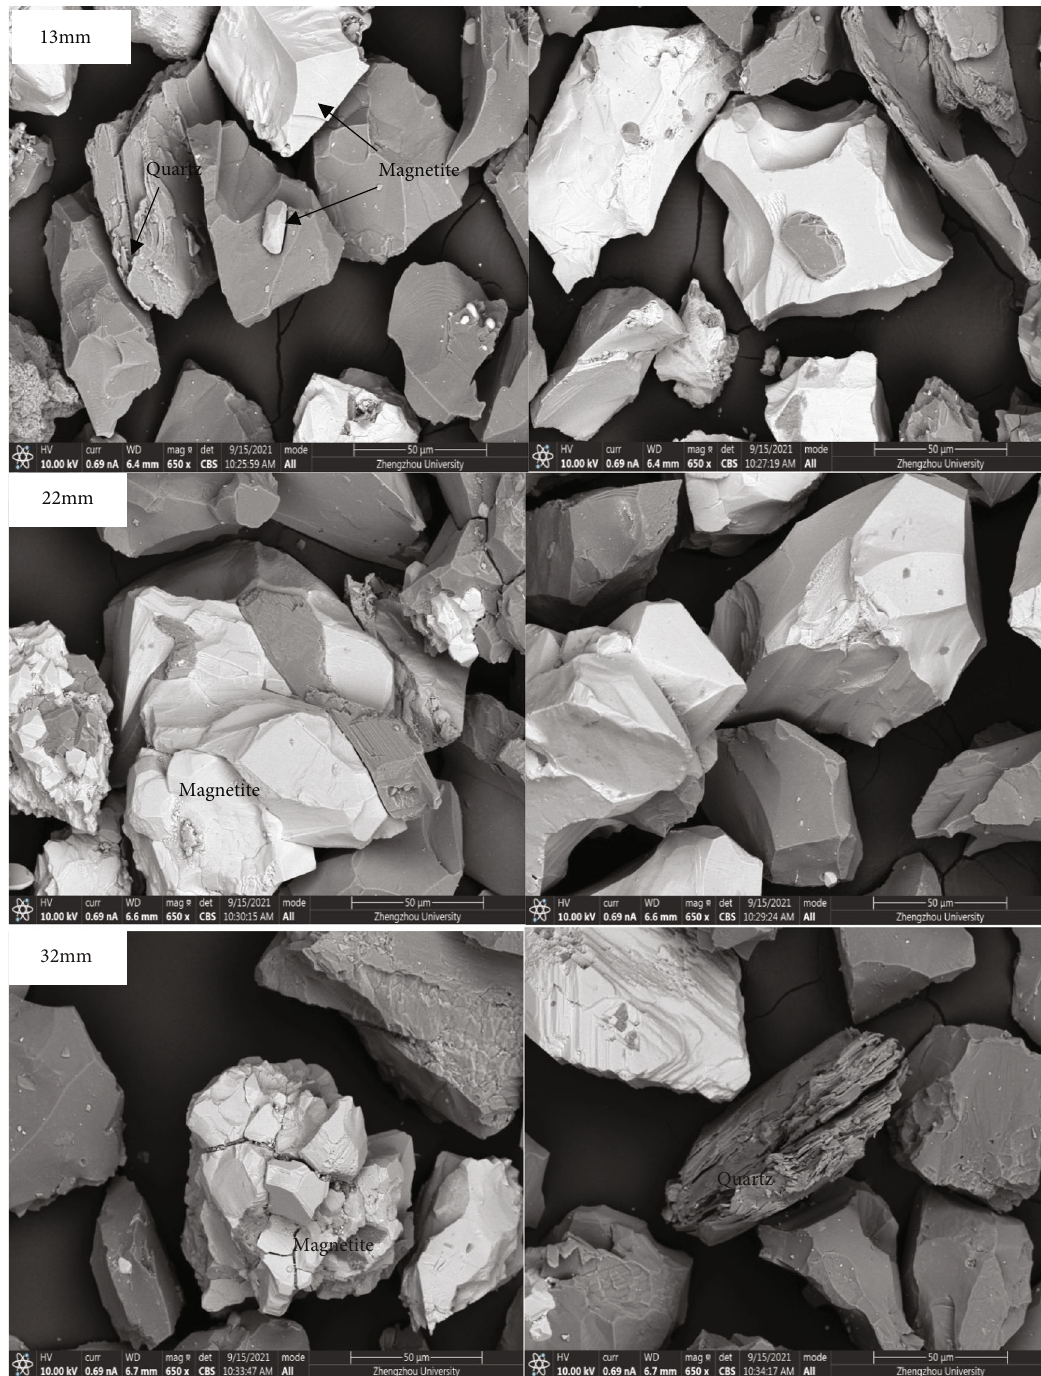
Figure 2: Particles morphology features in di ff erent grinding